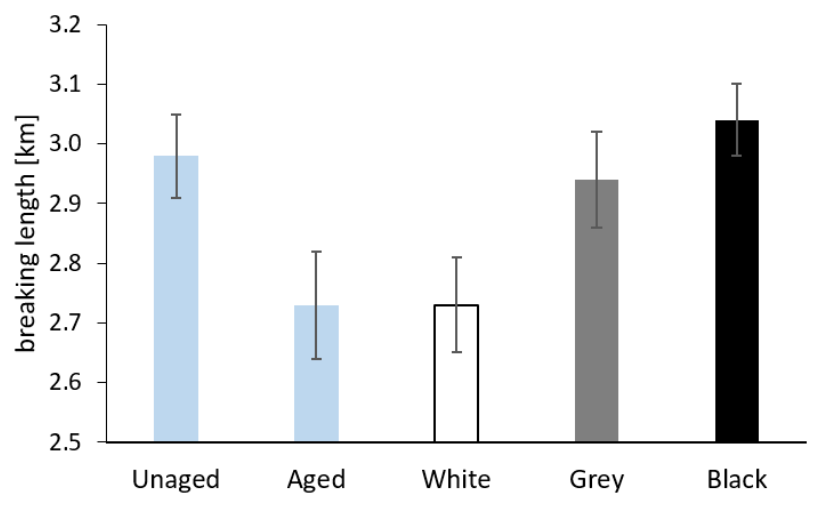
Figure 11. The breaking length of Whatman Grade 1 paper before aging (Unaged), after artificial aging without contact with PE foam (Aged), and in contact with the tested PE foams.